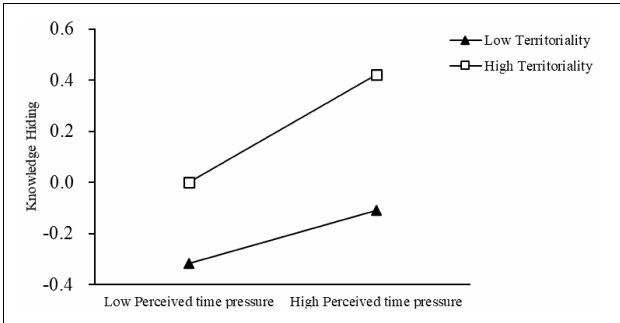
FIGURE 2 | Moderating effects of different perceived time pressure levels.